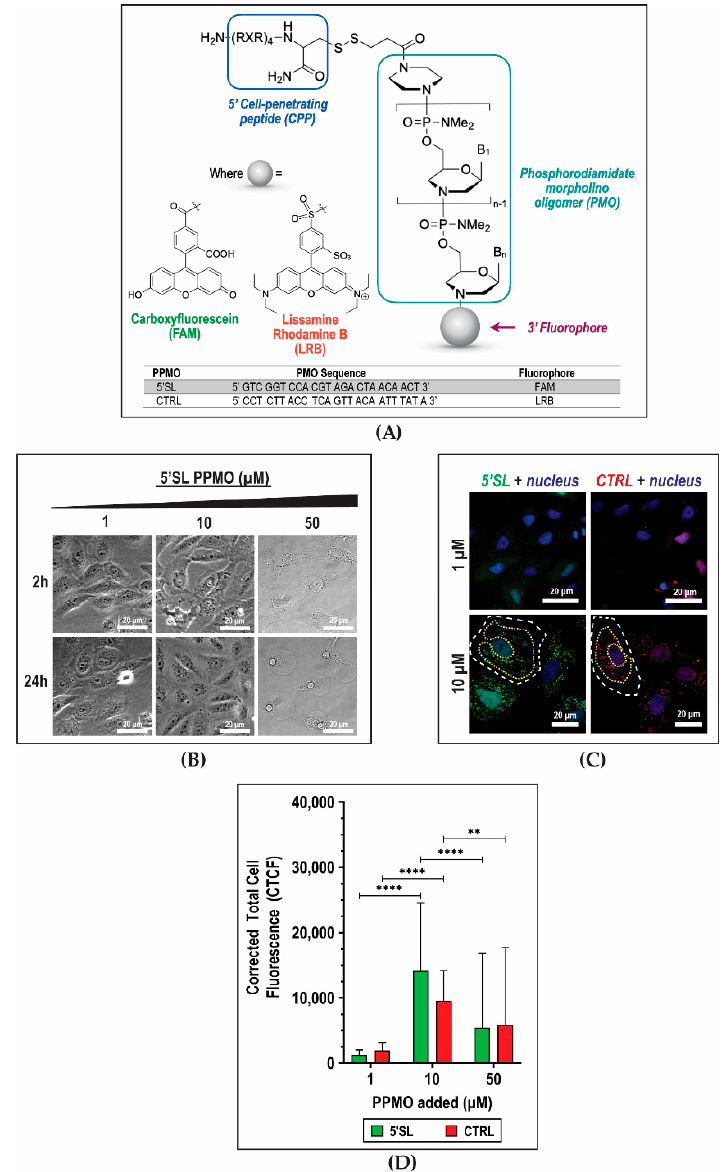
Figure 1. Peptide-conjugated phosphorodiamidate morpholino oligomers (PPMOs) as fluorescence imaging probes. ( A ) Schematic diagram of PPMO structure. Within the phosphorodiamidate morpholino oligomer (PMO) structure, the nuclease-resistant phosphorodiamidate bond is shown inside the bracket. The cell-penetrating peptide (CPP) (RXR) 4 B is attached to the 5 ′ -end of the PMO, while a fluorophore is conjugated at the 3 ′ -end. The DENV2-targeted 5 ′ SL PPMO is tagged with carboxyfluorescein (FAM), and the non-targeted unrelated control (CTRL) PPMO is tagged with lissamine rhodamine B (LRB). ( B – D ) Effect of PPMO concentration on viability and imaging contrast in monkey kidney Vero cells. Representative ( B ) phase-contrast and ( C ) deconvoluted fluorescence images are shown, taken at 2 and 24 h, and 24 h, respectively. Cells are incubated for 10 min with different concentrations of PPMOs. ( D ) Quantification of fluorescence signals in cells incubated with di ff erent PPMO concentrations. The corrected total cell fluorescence (CTCF) is calculated by subtracting the contribution of background from the integrated fluorescence density within the regions of interest (ROIs) drawn around cells. The cell boundary is outlined in white dashed lines, and sample ROIs used in fluorescence signal quantification are outlined in yellow dotted lines. Columns represent mean values, and error bars represent the standard deviation. An unpaired t -test is used to compare means. **, p < 0.005; ****, p < 0.0001.